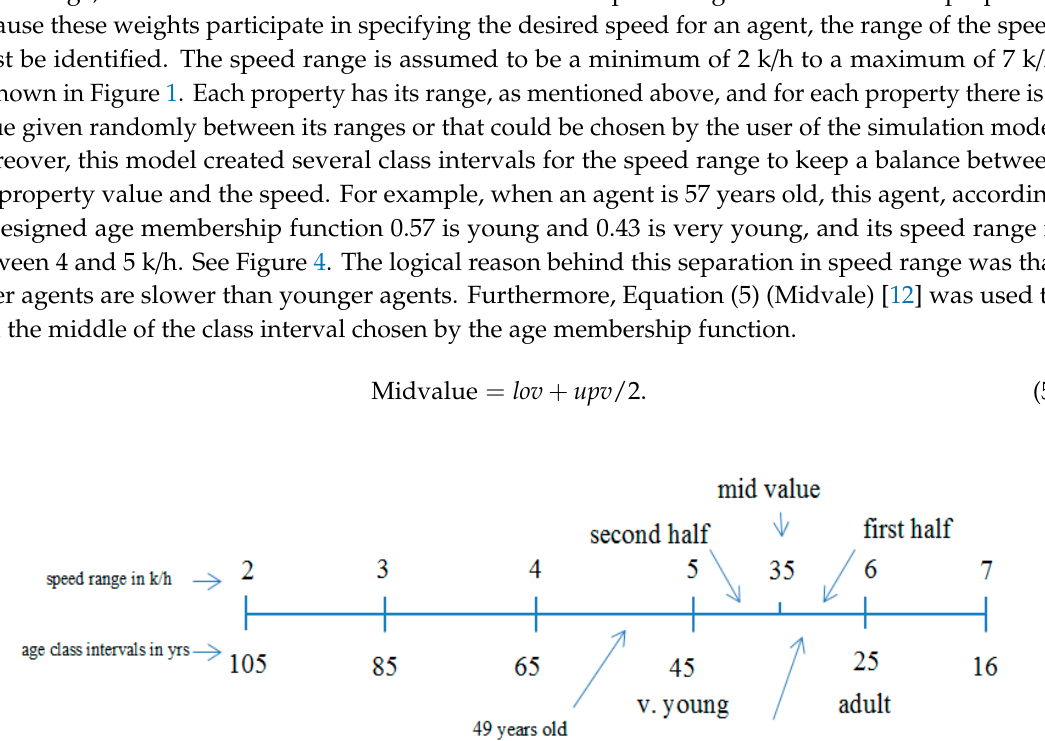
Figure 4. How the weights of an agent’s properties are identified [12].